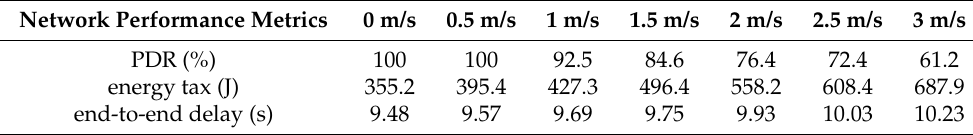
Table 2. Experimental results of different nodes speed with 1000 nodes.